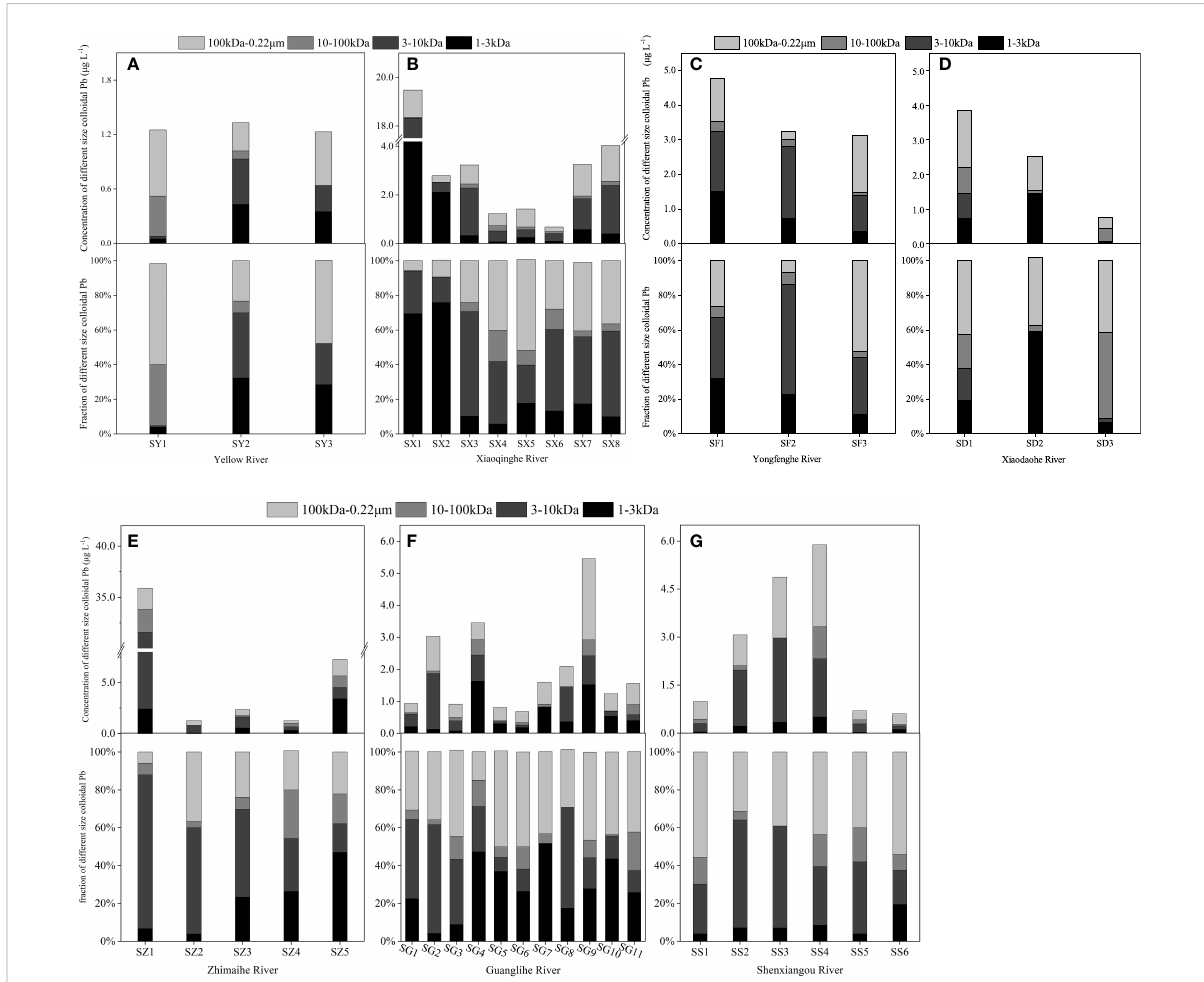
FIGURE 5 The concentration and fractionation of different sizes of colloidal lead (Pb). (A) The concentration and fractionation of different sizes of colloidal Pb in the Yellow River; (B) the concentration and fractionation of different sizes of colloidal Pb in the Xiaoqinghe River; (C) the concentration and fractionation of different sizes of colloidal Pb in the Yongfenghe River; (D) the concentration and fractionation of different sizes of colloidal Pb in the Xiaodaohe River; (E) the concentration and fractionation of different sizes of colloidal Pb in the Zhimaihe River; (F) the concentration and fractionation of different sizes of colloidal Pb in the Guanglihe River; and (G) the concentration and fractionation of different sizes of colloidal Pb in the Shenxiangou